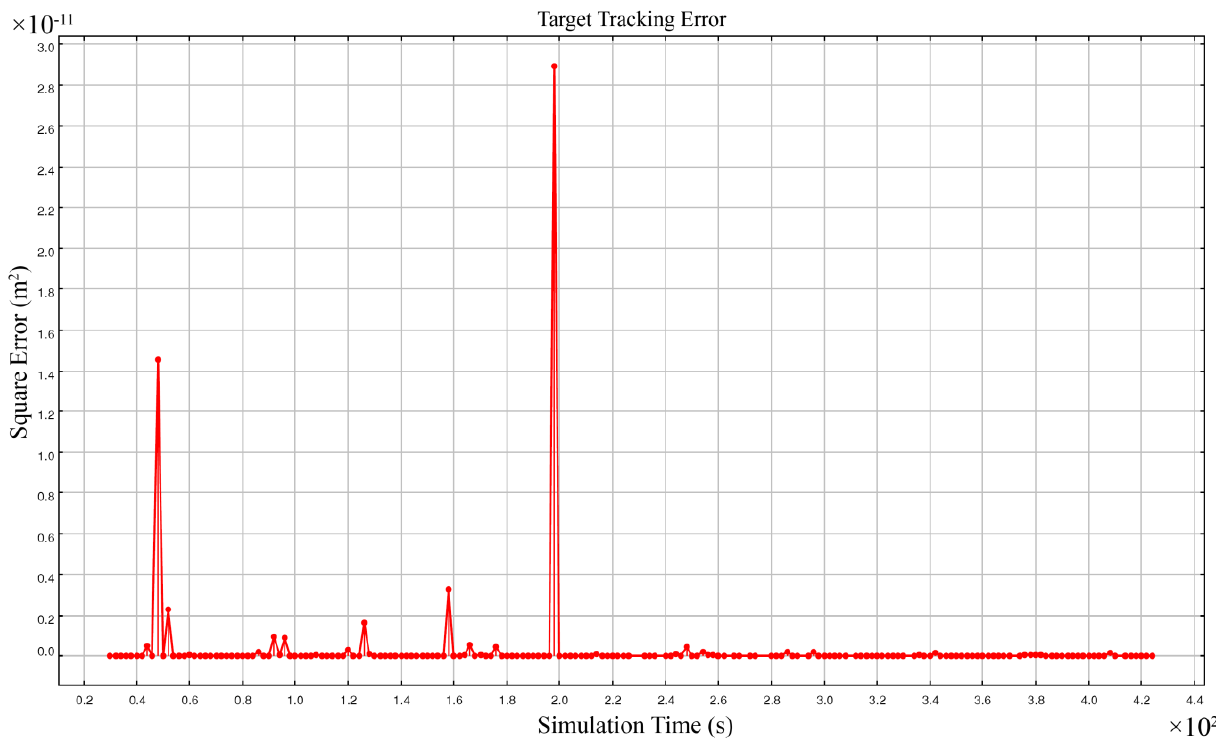
Figure 11. Square error of 3-dimensional acoustic target tracking using FCEP